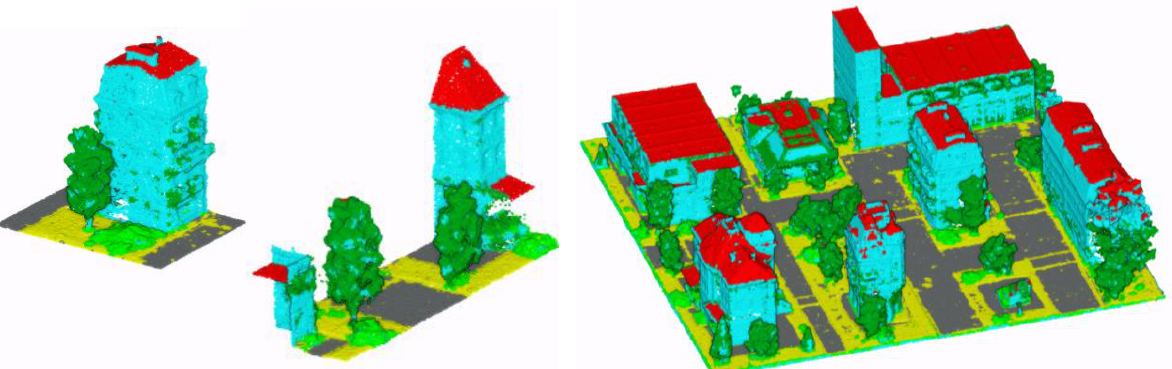
Figure 8. Classified evaluation data (left) and classified point cloud (right) for 6 classes: ground (grey), grass (yellow), shrub (light green), tree (dark green), facades (cyan), roof